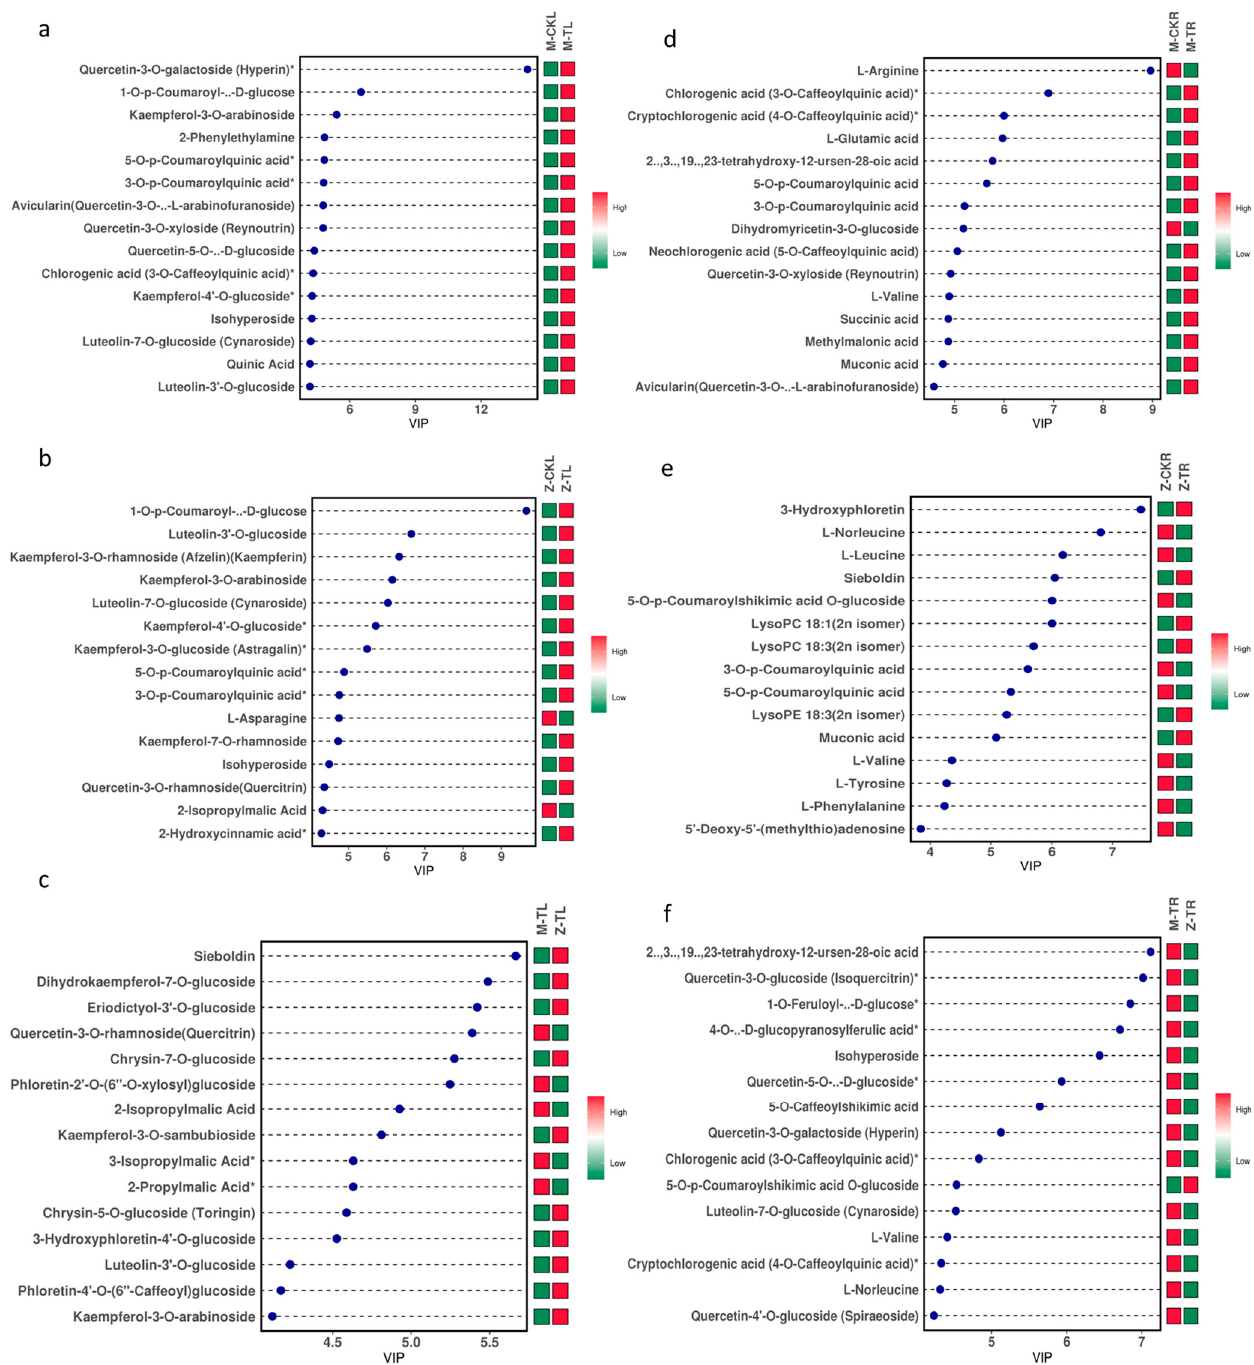
Figure 7. The top 15 DAMs based on the values of VIP in different combinations. ( a ) The top 15 DAMs based on the values of VIP in leaves of M-CKL vs. M-TL. ( b ) The top 15 DAMs based on the values of VIP in leaves of Z-CKL vs. Z-TL. ( c ) The top 15 DAMs based on the values of VIP in leaves of M-TL vs. Z-TL. ( d ) The top 15 DAMs based on the values of VIP in roots of M-CKR vs. M-TR. ( e ) The top 15 DAMs based on the values of VIP in roots of Z-CKR vs. Z-TR. ( f ) The top 15 DAMs based on the values of VIP in roots of M-TR vs. Z-TR.